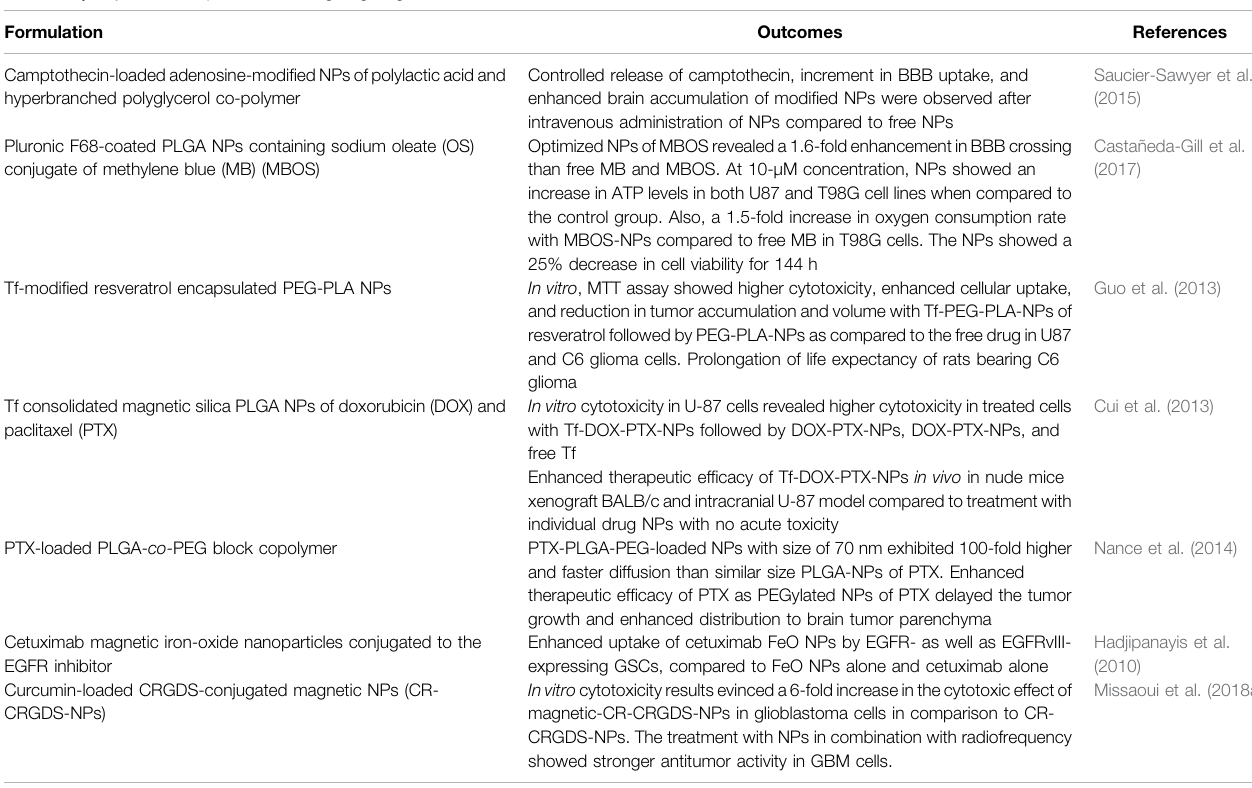
TABLE 1 | Polymeric nanoparticles for drug targeting to brain